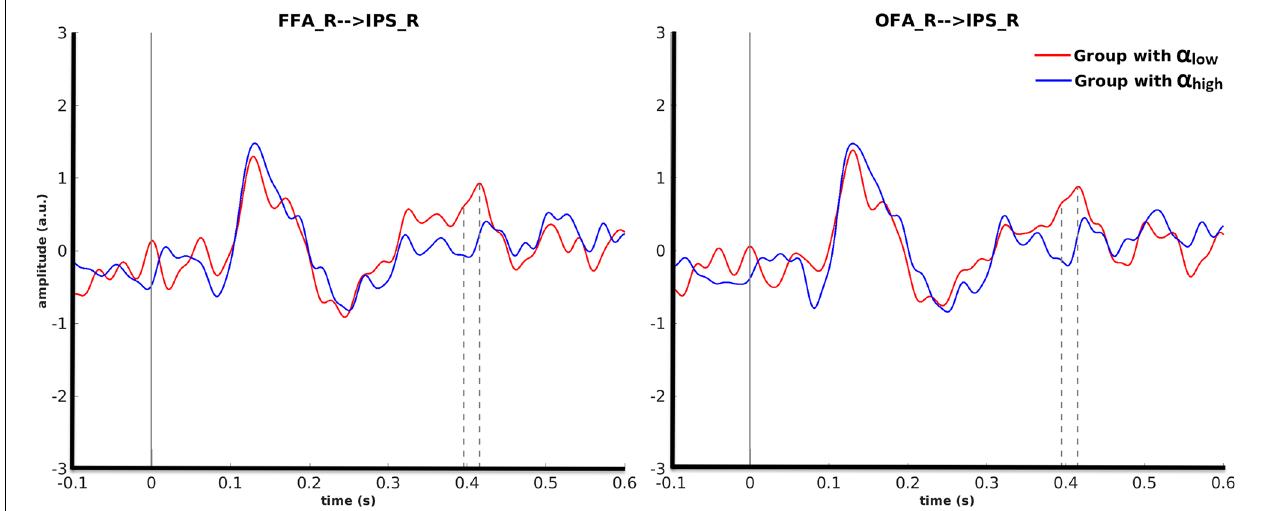
FIGURE 5 | Grand average over the participants’ evoked responses to motorcycles stimuli for the α low and α high conditions in the right IPS. The left columns represent the time courses when FFA was considered as the seed ROI and the right column is with regard to OFA as the seed